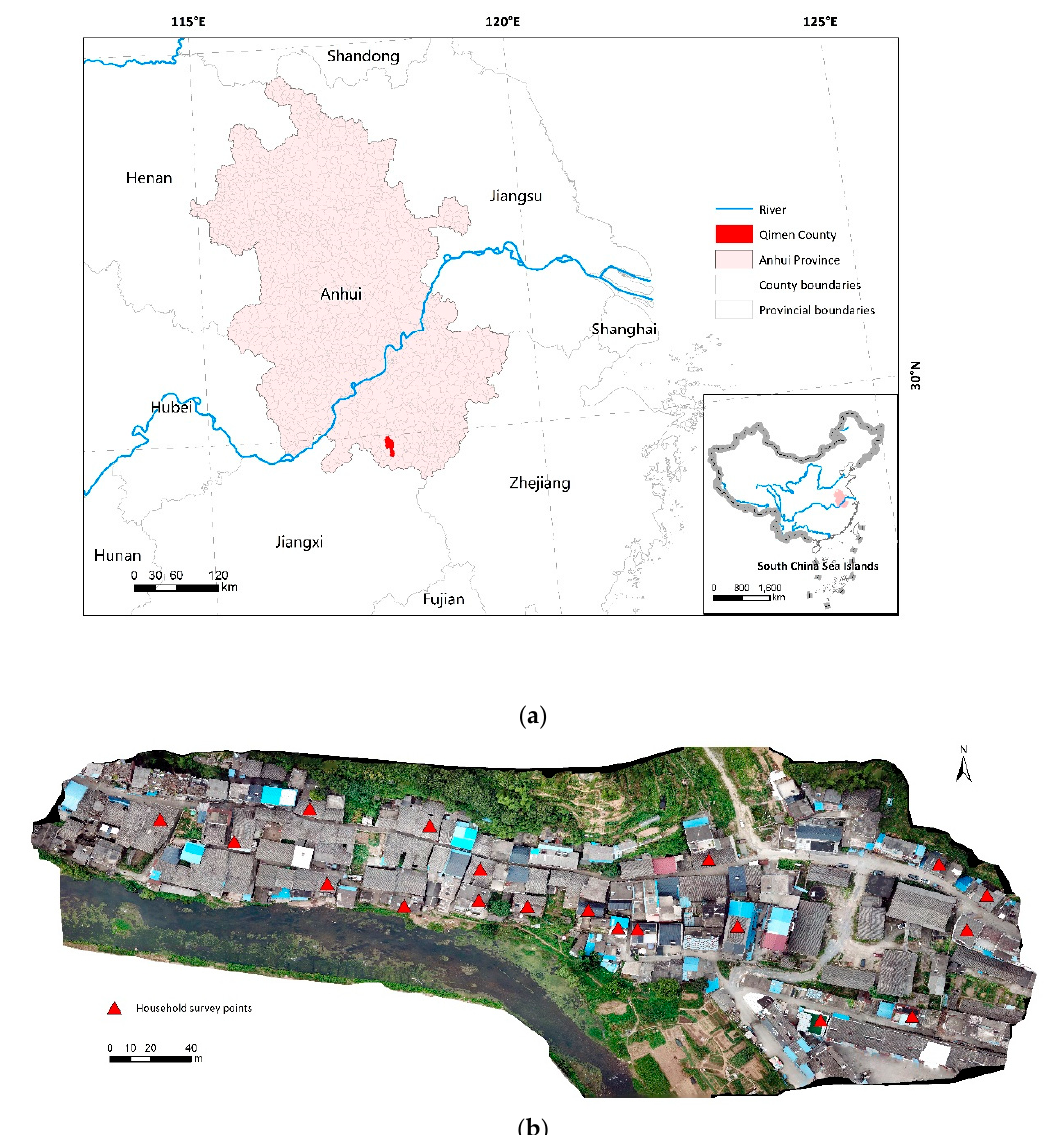
Figure 1. Study area: ( a ) Qimen county, Anhui province, ( b ) Jianfeng village, Qimen county. The red triangles in Figure 1b indicate household survey locations.